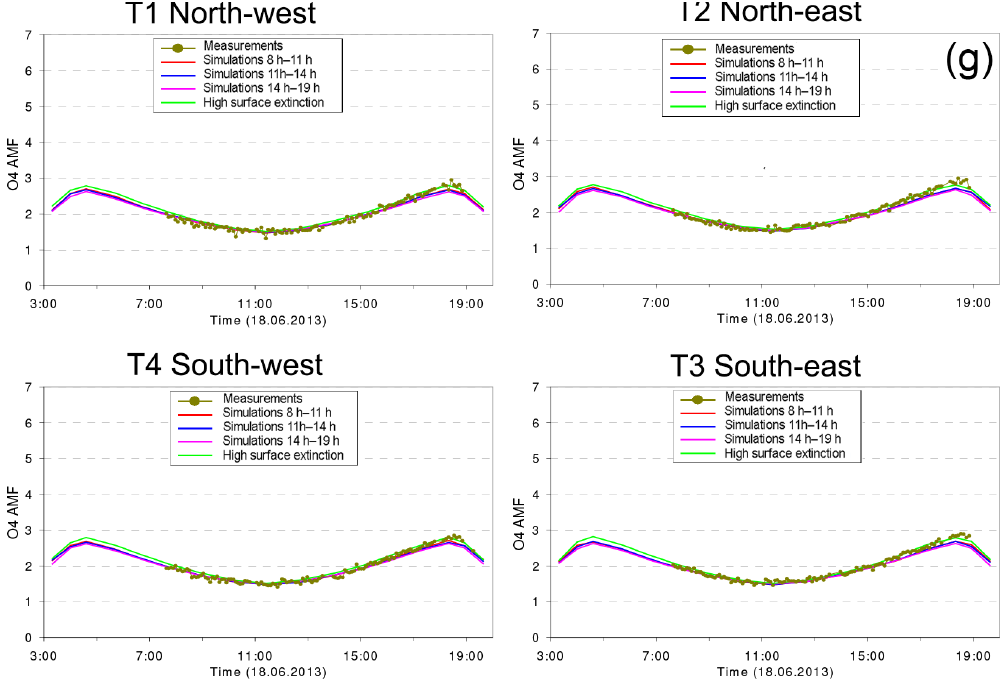
Figure A4. (a) Comparison results for 1 ◦ elevation angles on 18 June 2013 including the RTM results for the modified aerosol extinc- tion profile (green line). (b) Comparison results for 3 ◦ elevation angles on 18 June 2013. (c) Comparison results for 6 ◦ elevation angles on 18 June 2013. (d) Comparison results for 10 ◦ elevation angles on 18 June 2013. (e) Comparison results for 15 ◦ elevation angles on 18 June 2013. (f) Comparison results for 30 ◦ elevation angles on 18 June 2013. (g) Comparison results (only O4 AMFs) for 90 ◦ elevation angles on 18 June